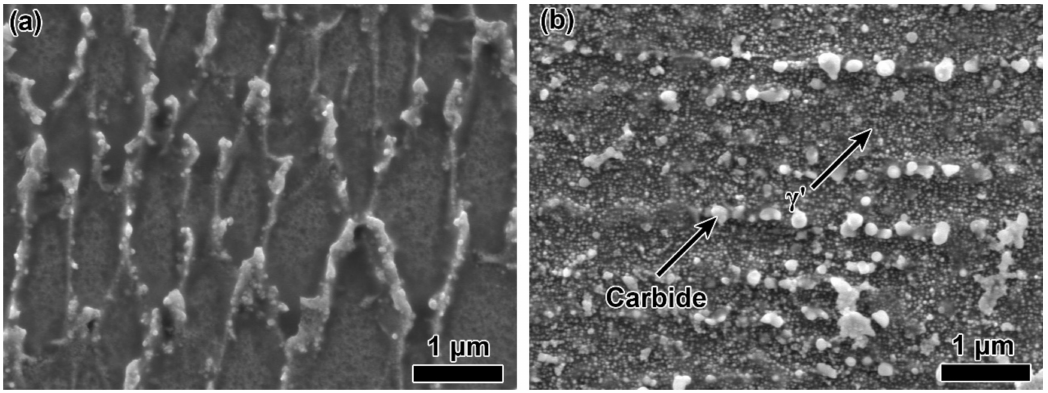
Figure 3. SEM images showing microstructure of the GTD222 superalloy: ( a ) as-built sample, ( b ) HTed sample. The substructure of the as-built GTD222 was shown in Figure 4. Qualitatively, the dislocation density in the as-built GTD222 was high and dislocations were tangled at the boundaries of the columnar, as shown in Figure 4a. The method determines the dislocation density was introduced in the literature [26]. The selected area electron diffraction of the green circle area marked in Figure 4a shows that no precipitate was formed in the as-built